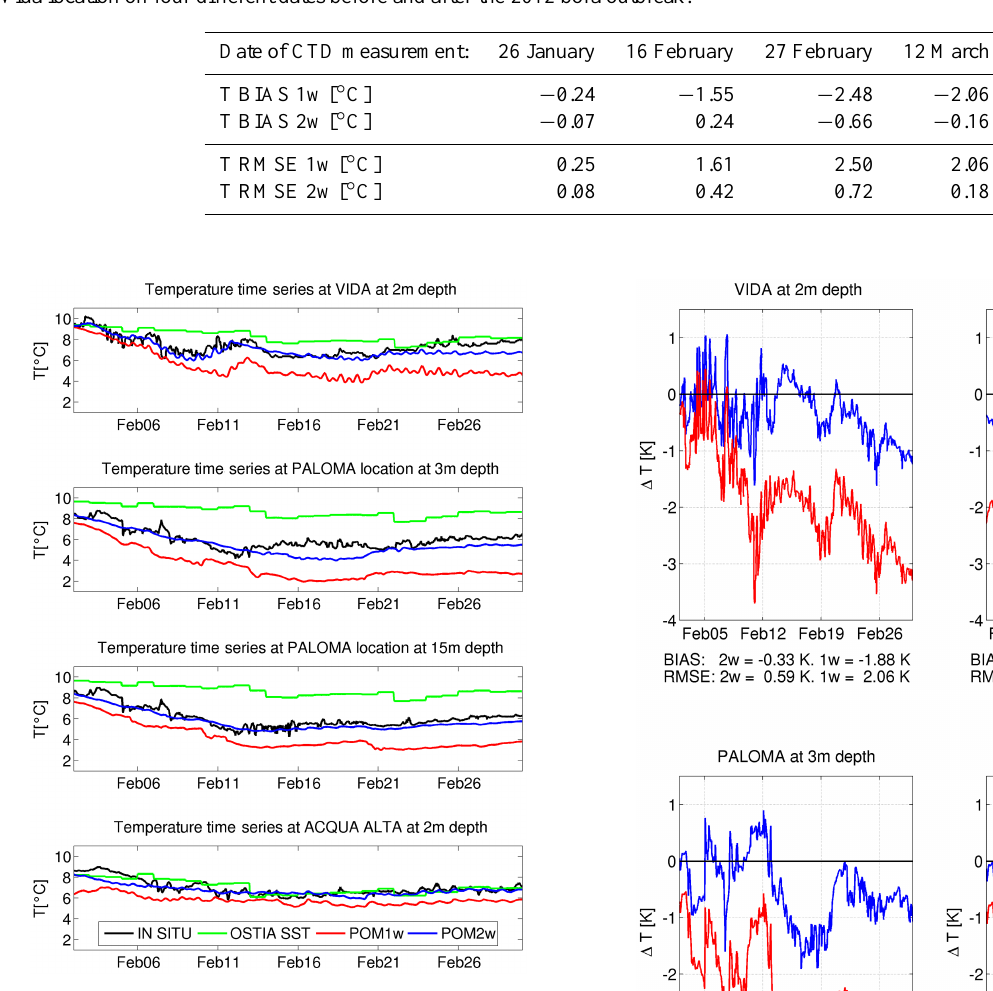
Figure 11. Modeled and observed temperatures at Vida, Paloma and Acqua Alta locations. Observed in situ temperatures are plotted with a black line, OSTIA SST boundary condition for ALADIN1w with a green line, POM1w modeled temperature with red line and POM2w modeled temperature with a blue line. First row: tempera- tures at Vida location. Second row: temperatures for Paloma loca- tion at 3m depth. Third row: temperatures at Paloma at 15m depth. Fourth row: temperatures for Acqua Alta locations at 2m depth.